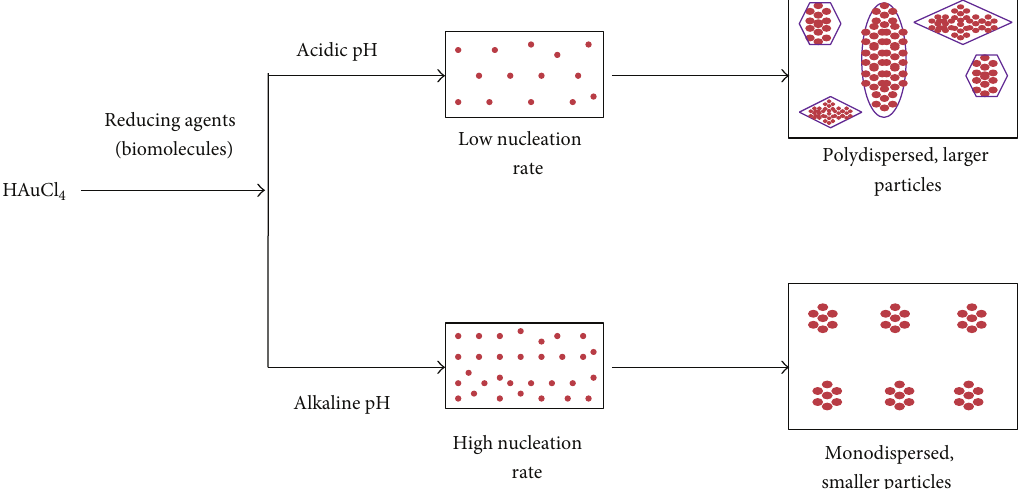
Streptococcus mutans .